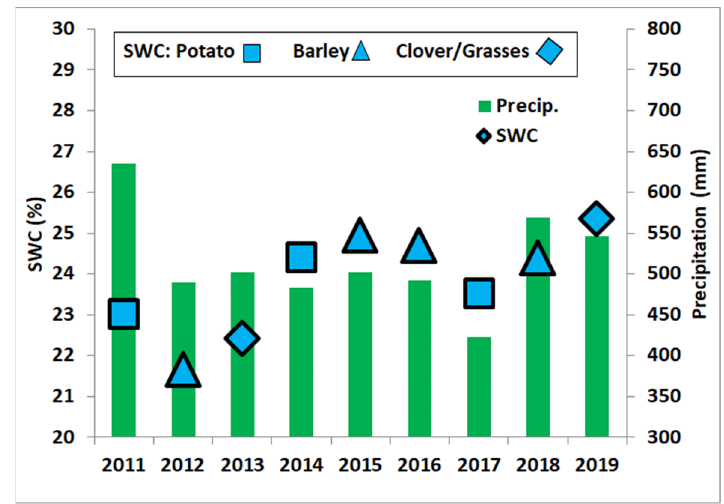
Figure 4. Average soil water content (SWC) and precipitation for each growing season during the study period (Note: 2010 growing season data [incomplete] not included).